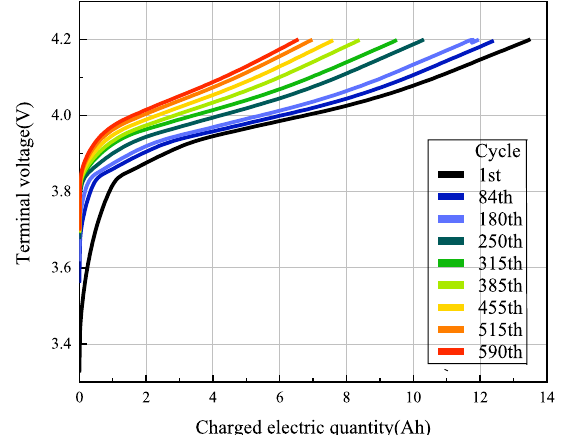
Fig. 4 V–Q curve of B0005 battery